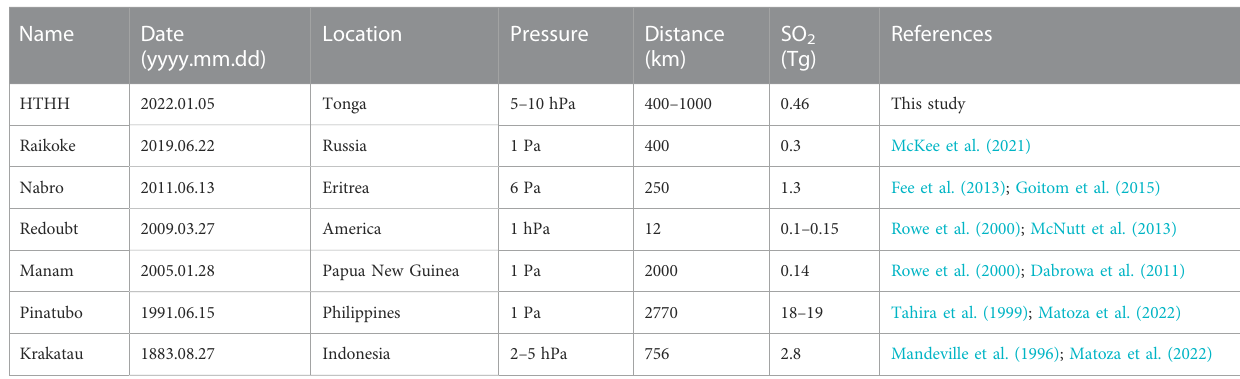
TABLE 1 Infrasound pressures and SO 2 emissions for individual